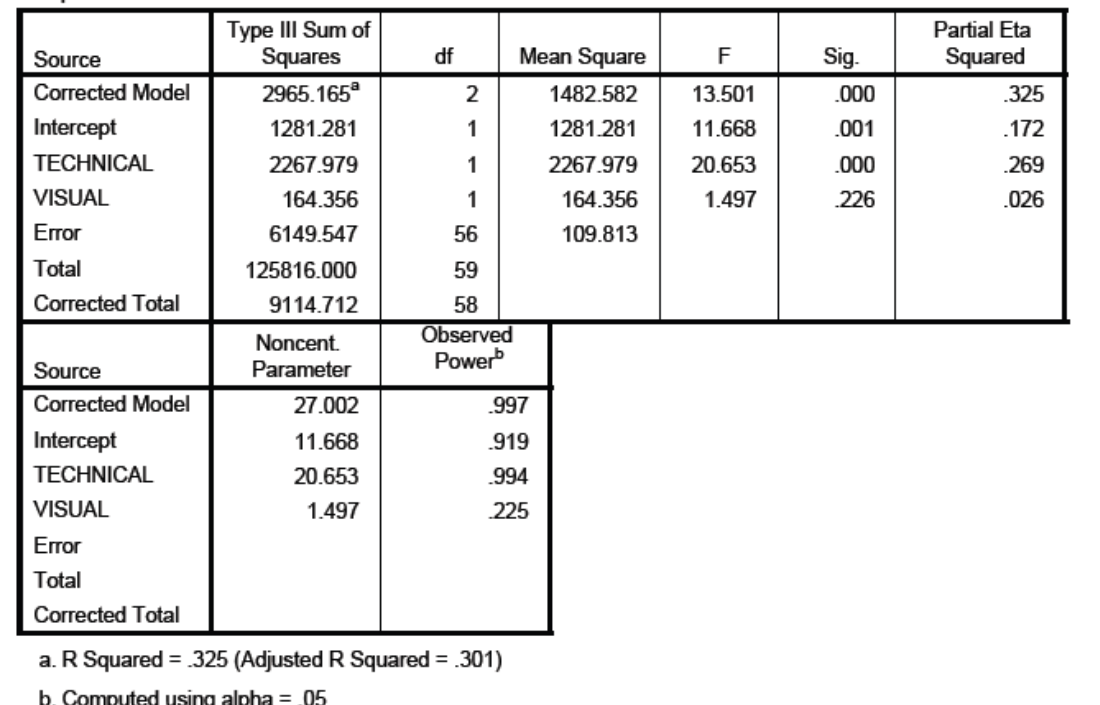
Figure B.11. ANCOVA analysing engagement levels in regard to visual preference using data adjusted for technical